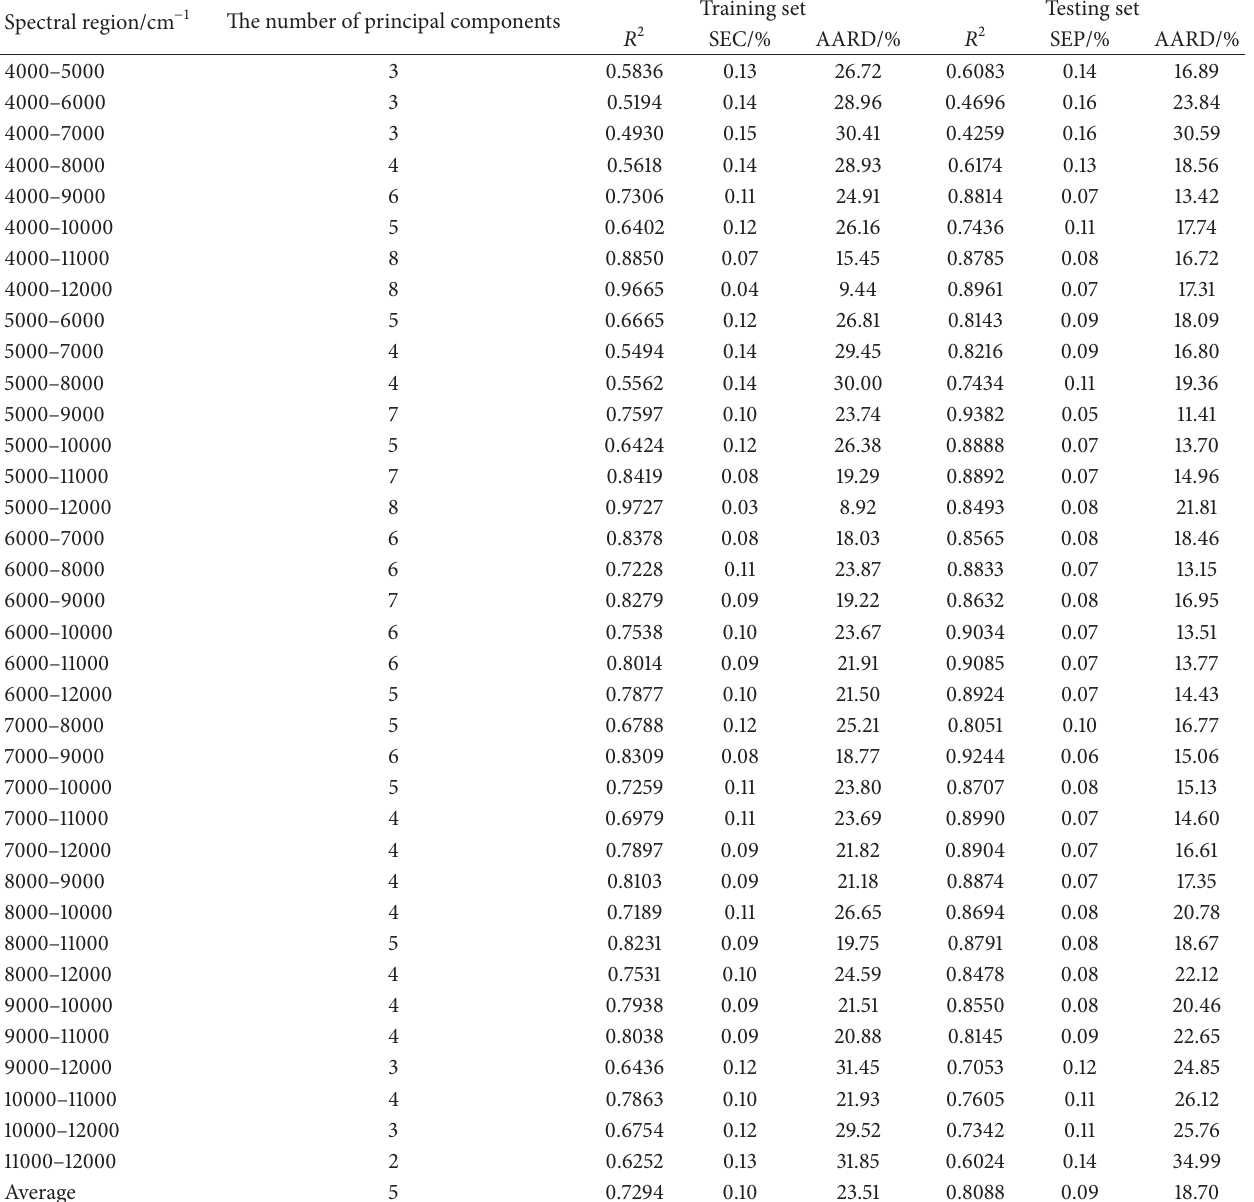
Table 2: Influence of different spectral regions on prediction results of QPLS models for quantitative determination of germinability of Puccinia striiformis f. sp. tritici urediospores.